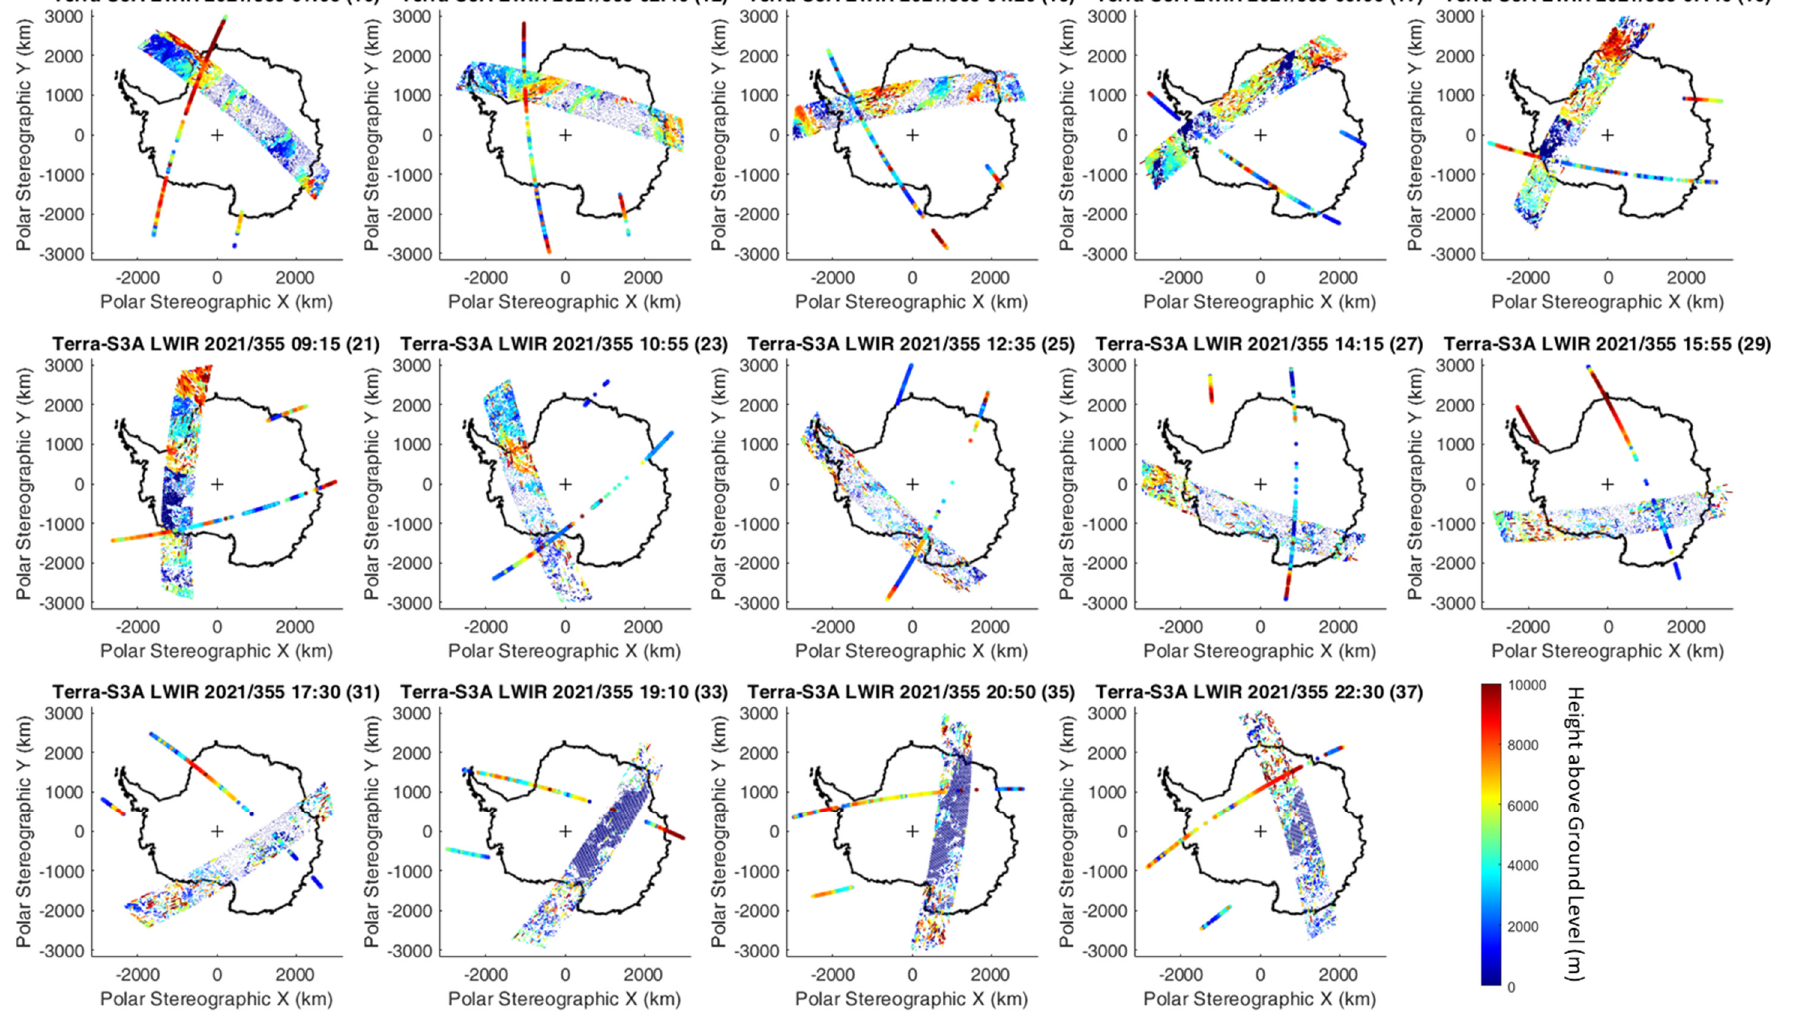
Figure A1. Terra and Sentinel-3A retrievals for South Polar summer (21 December 2021, LWIR).